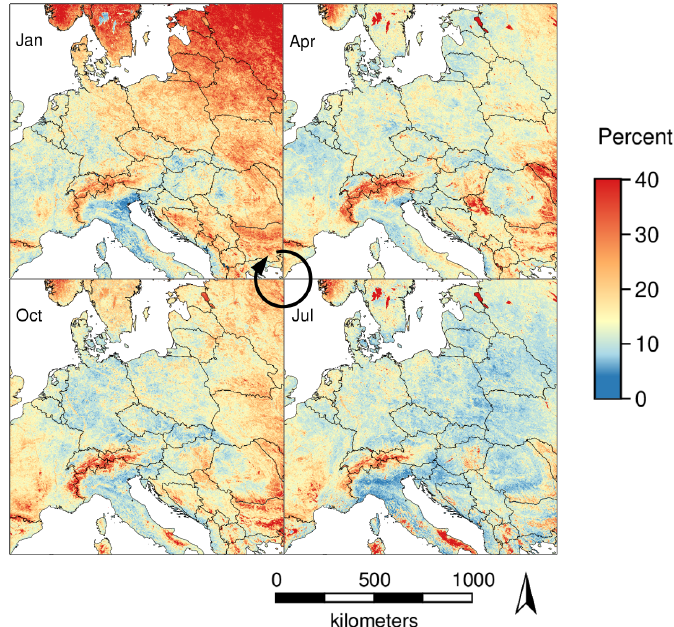
Figure 5. Spatial distribution of the percentage of LST outliers aggregated over the years 2003 to 2016 for the months January, April, July, and